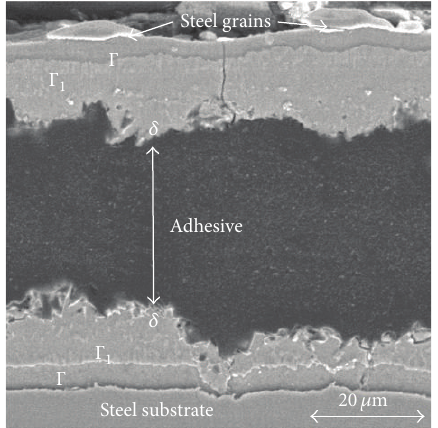
Figure 4: SEM image of cross section of bonded